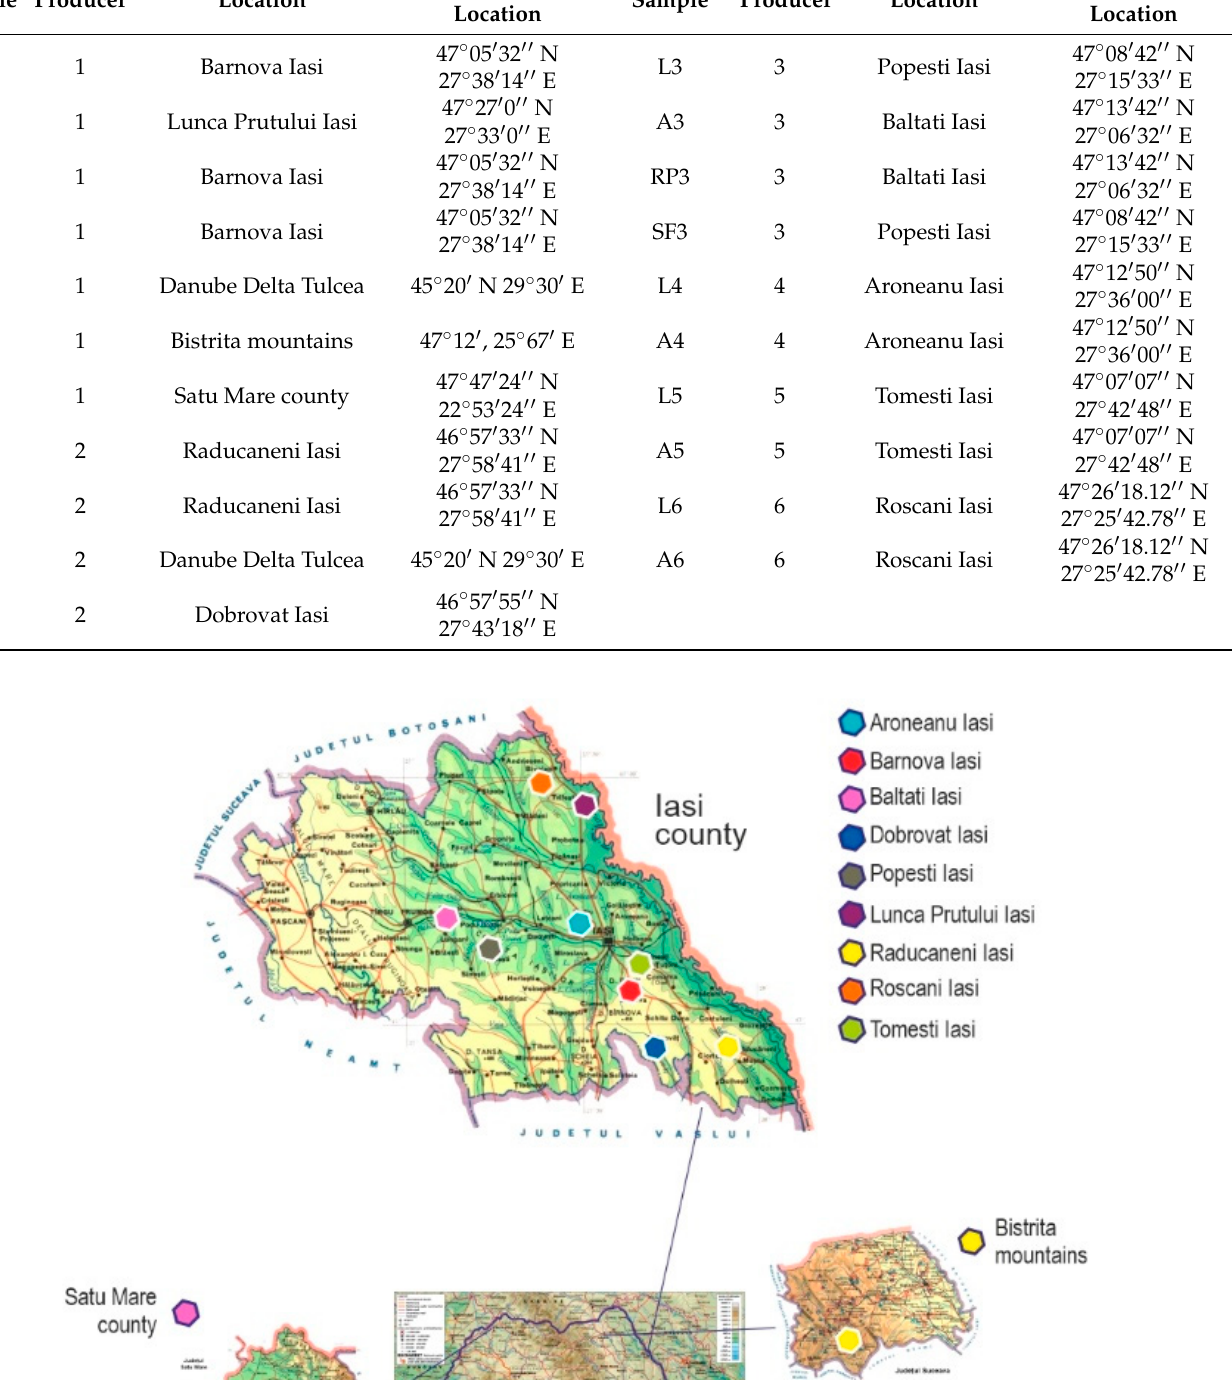
3 of 26 Table 1. Sample description. Sample Pro- ducer